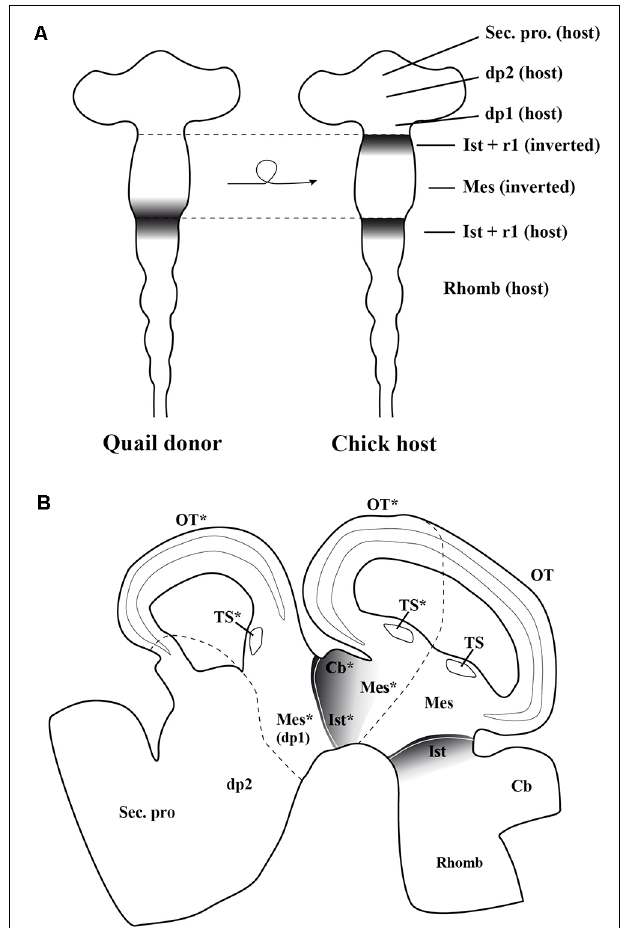
FIGURE 7 | (A) Schematic representation of the chick/quail chimeric experiments in which the quail (donor) “mesencephalic” vesicle at stage HH10, containing both the mesencephalic primordium and the rostral part of the isthmocerebellum, was grafted into a chick (host) embryo after inversion of its rostrocaudal axis (Marín and Puelles, 1995). The En2-expressing area is represented by gray areas. In the resulting chimeric embryo, the grafted isthmocerebellum was positioned just in contact with the host pd1 (diencephalon), whereas the rostra1 “mesencephalic” vesicle was in direct interaction with the staying host pro-rhombomere 1, RhA1. (B) Sagittal section of the resulting chimeric embryo in a long-survival analysis. The grafted-rotated portion of the neural tube is located between both dotted lines. The rostral and caudal portions of isthmocerebellum kept its original phenotype giving rise to the cerebellum (Cb) and isthmic nuclei (Ist). The grafted mesencephalic primordium formed a bicaudal phenotype, as showed by the symmetry of its cytoarchitecture organization of the optic tectum (OT) and a duplication of the torus semicirculais (TS). The host dp1 changed its fate for a complex caudal mesencephalic structure (OT plus TS), the phenotype of the contiguous dp2 not being perturbed. Asterisks, ectopic structures observed in experimental studies. Mes, mesencephalon; r1, rhombomere 1; Rhomb, rhombecephalon; Sec. pros,